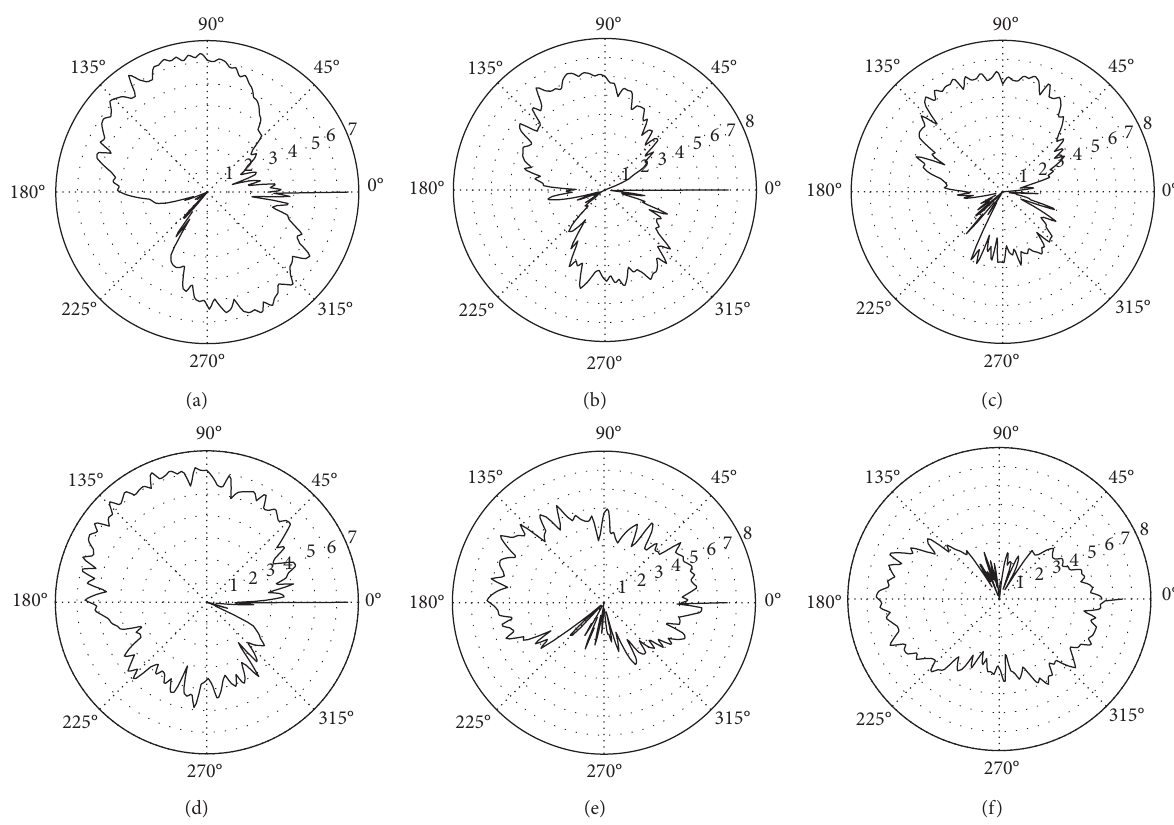
Figure 9: Azimuth view of the radiation pattern: (a) 2.3GHz, (b) 2.4 GHz, (c) 2.6GHz, (d) 3.5 GHz, (e) 5.2 GHz, and (f)